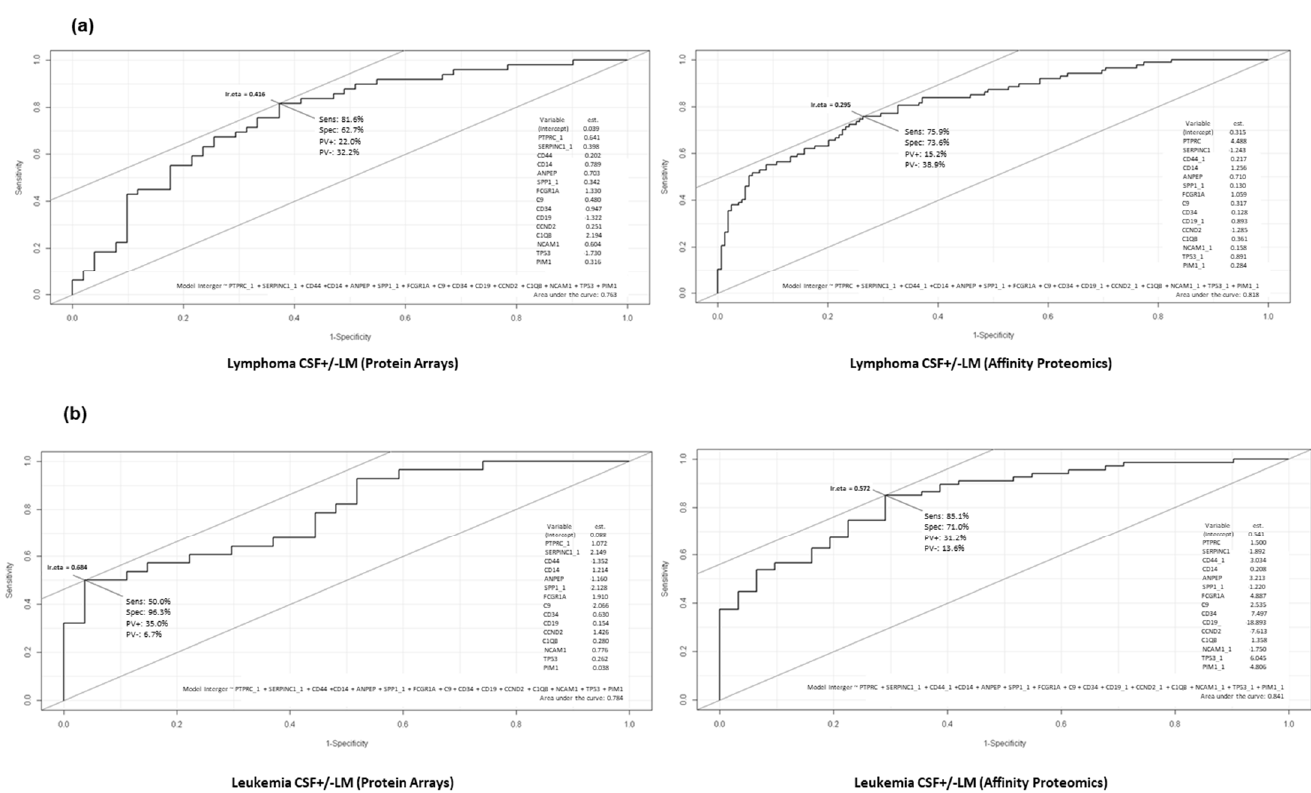
Figure 8. ( a ) ROC analysis of potential biomarker panel on CSF + LM (lymphoma) by protein arrays and affinity proteomics (as described in Materials and Methods section). ( b ) ROC analysis of potential biomarker panel on CSF + LM (leukemia) by protein arrays and affinity proteomics (as described in Materials and Methods section).